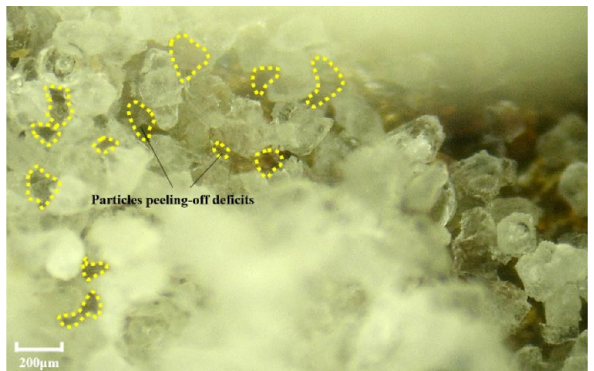
Fig. 18 Microscopic view of discrete particle detachment deficits in the middle of the No.2 sample